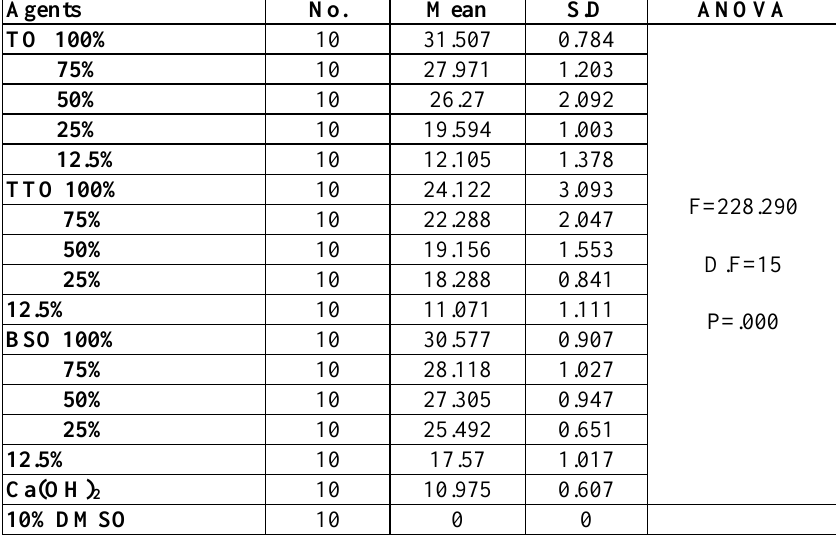
Table 1: ANOVA, Mean, S.D of inhibition zone in millimeter of E.faecalis to different concentrations and different agents (Agar well diffusion methods). Agents